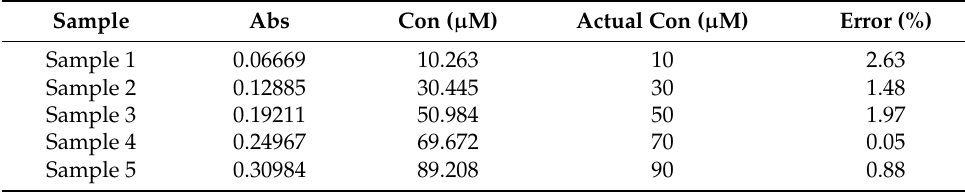
Figure 5. ( A ) Actual detection of color changes for different samples. ( B ) UV–vis absorbance spectra changes for different samples. Table 2. The actual detection effect of different